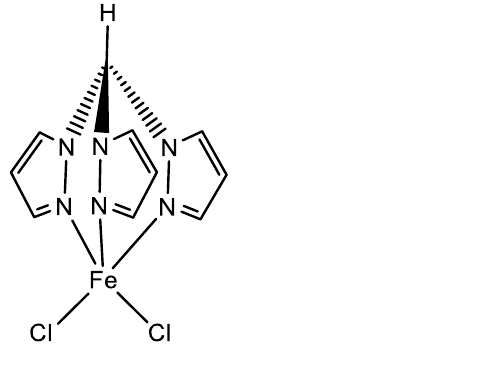
Figure 3. Iron(II) C-scorpionate complex structure. Adapted from [23].